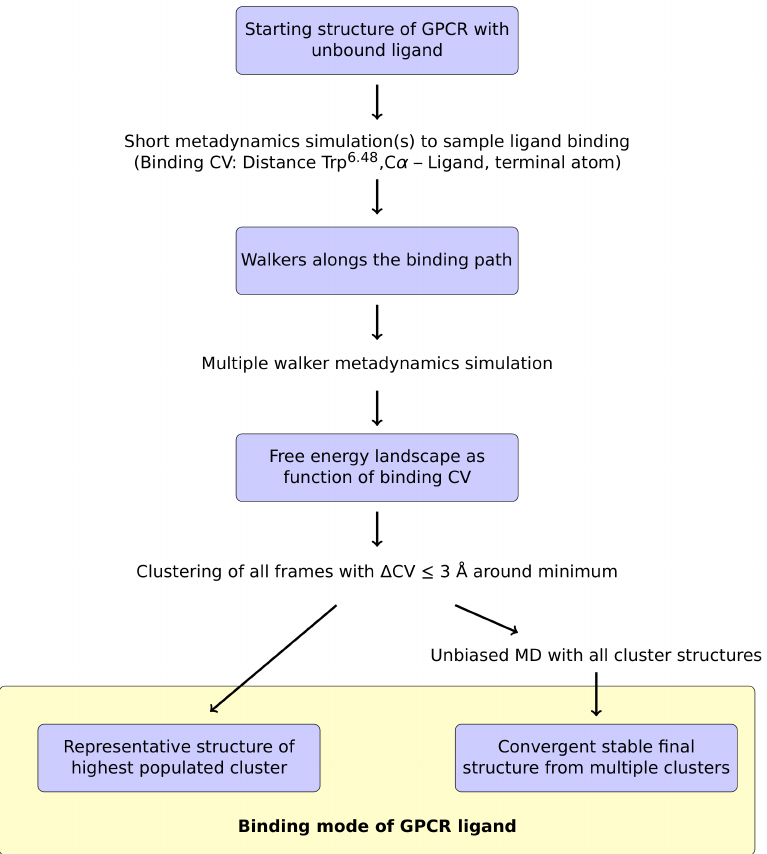
Figure 1. Overview of the proposed metadynamics-based protocol for the determination of ligand modes to GPCRs. See text for a detailed